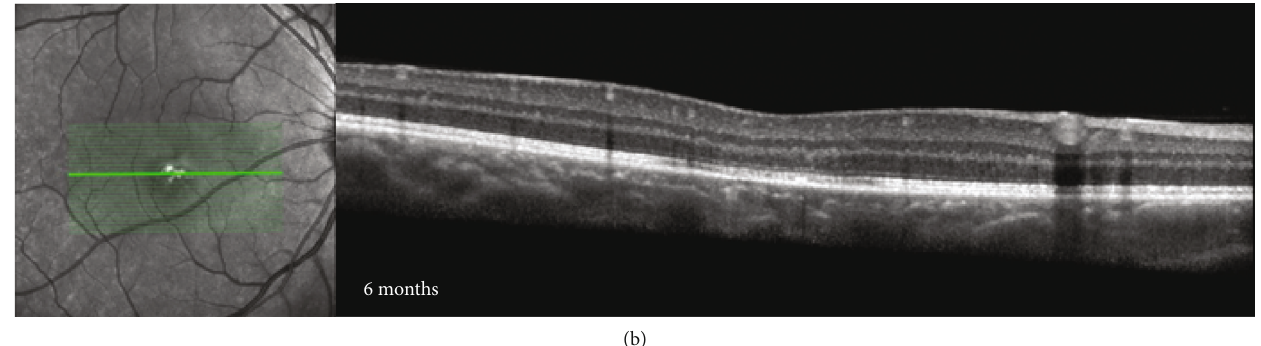
Figure 1: Wide- fi eld fundus photography of the right eye (A) shows an ovoid, hypopigmented placoid lesion adjacent to the fovea. FAF (B) reveals corresponding hypoauto fl uorescence and surrounding areas of hyperauto fl uorescence with irregular borders. Near-infrared re fl ectance (C) and spectral-domain optical coherence tomography (D) reveal speckled hyperre fl ectivity within the lesion and signi fi cant disruption of the outer retina, including the outer nuclear layer, ellipsoid zone, and retinal pigmented epithelium with choroidal hypertransmission. Early hyper fl uorescence with FA (E) precedes increased hyper fl uorescence of the macular lesion with discrete borders upon recirculation phase (F). Late-phase indocyanine green angiography shows multiple areas of hypocianescence in the right (G) greater than the left eye (H), including the area corresponding to the lesion. (b) Spectral-domain optical coherence tomography at 6 months after initial presentation shows improved attenuation in the outer plexiform